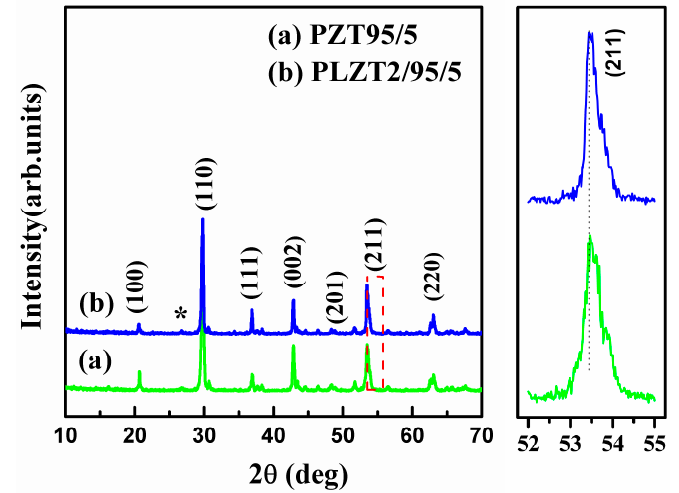
Figure 1. XRD patterns of PLZT2/95/5 ceramics sintered at 1250 °C for 5 h.